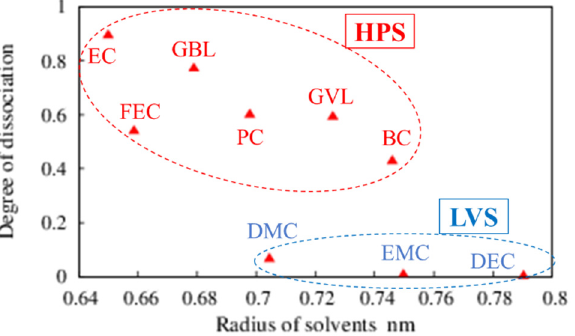
Figure 4. Correlation between molecular radius and coordination number of Li+.